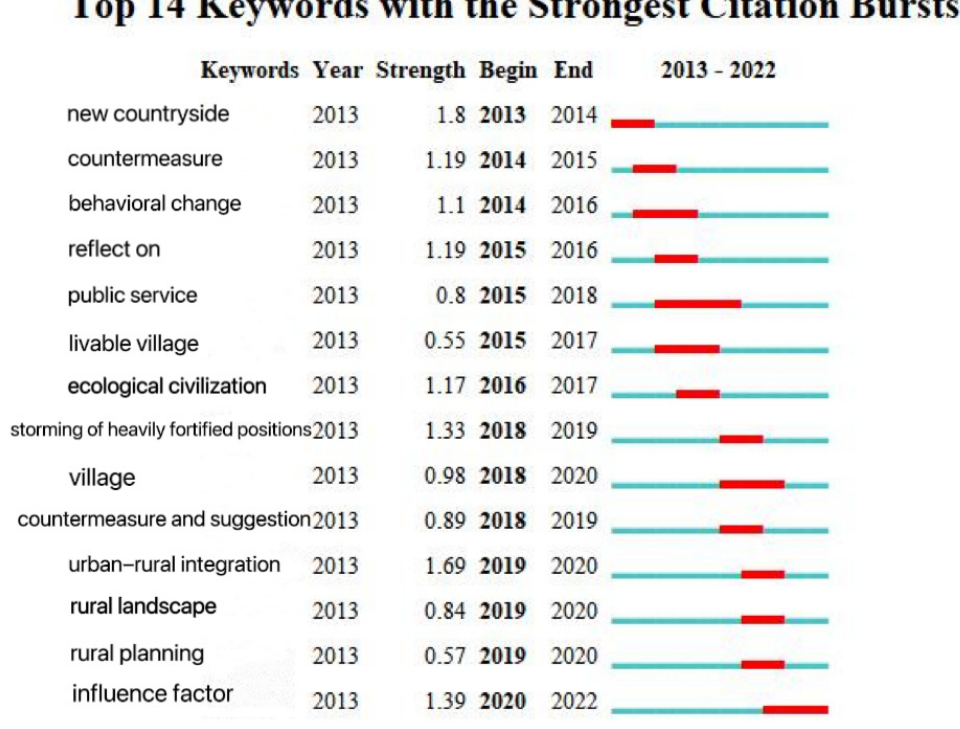
Figure 10. Prominence of keywords in rural human settlement environment research.